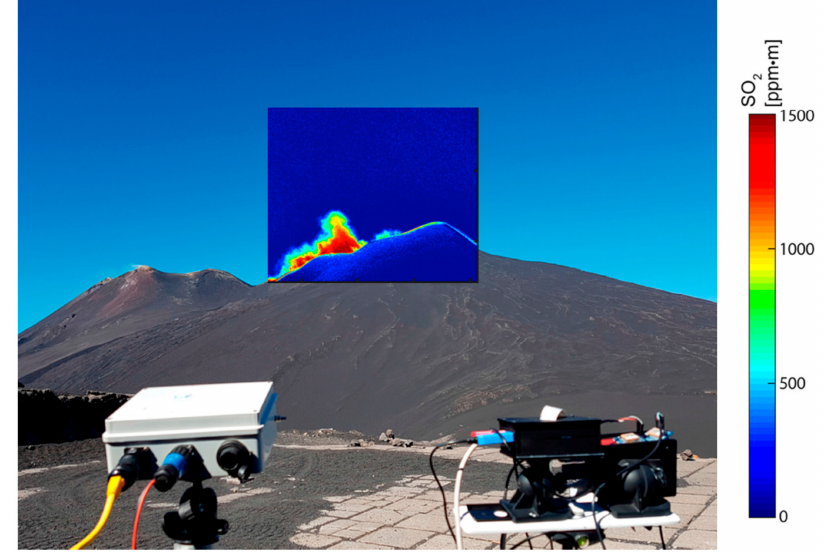
Figure 1. Deployment of inexpensive smartphone sensor-based ultraviolet (UV) camera instrumentation ( right ) in tandem with more traditionally applied scientific grade cameras ( left ) on Mt. Etna. A false colour gas column amount inset image is included in the graphic, with scale to right, for the cheaper units, which were based on modified Raspberry Pi cameras (Raspberry Pi Foundation, Cambridge, UK). For further detail, see